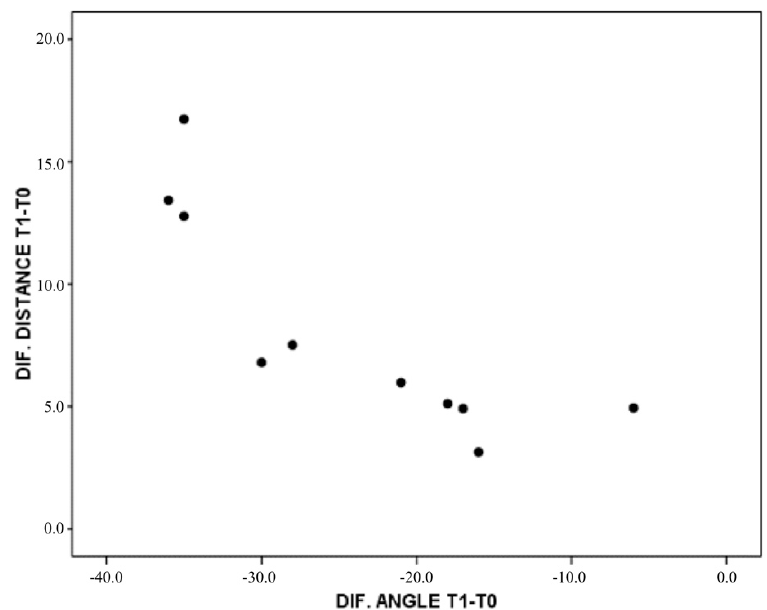
Figure 4. Prosthetic space gained in relation to reductions in angulation. It is clear from the scatter graph that the greater the reduction in angulation was (points towards the left on the horizontal axis), the greater the prosthetic space gained was (points higher up in vertical direction).